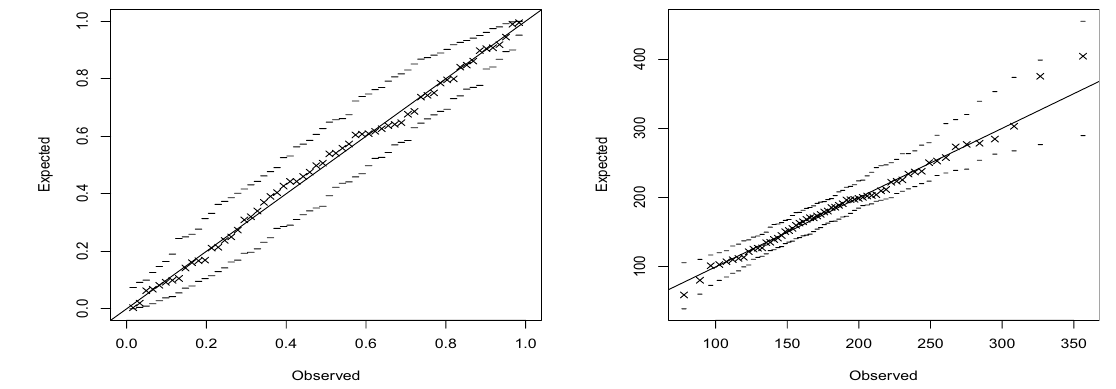
Figure 4. Probability (left) and quantile (right) plots for Bulawayo airport with 95% simulated confidence intervals (dashed lines). R software, version 4.1.2, https:// www.r- proje ct. org/ was used for plotting.